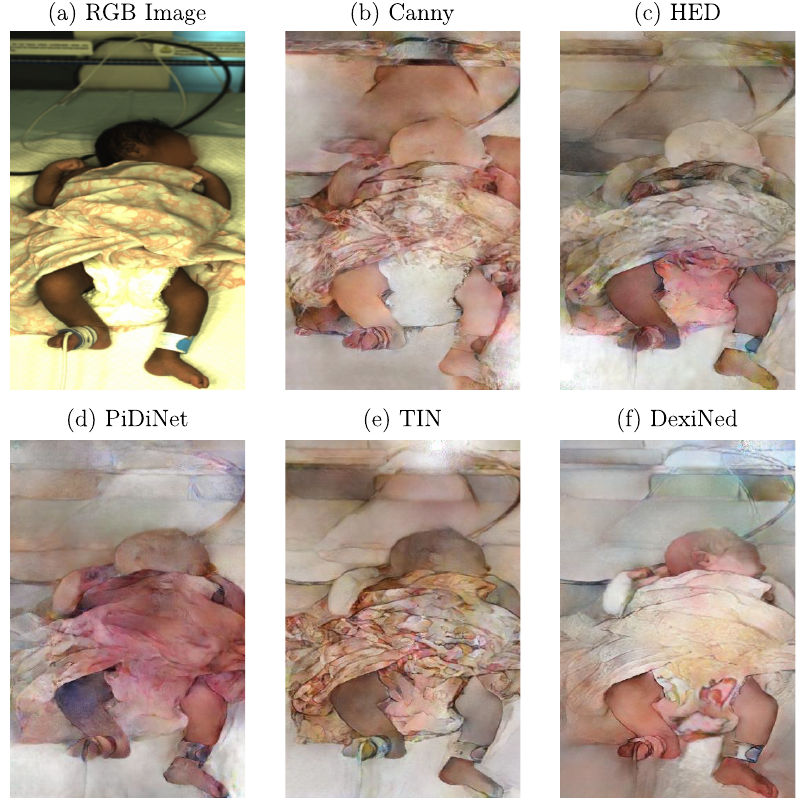
Figure 8. Example RGB frame with resulting images generated by cGAN using different edge